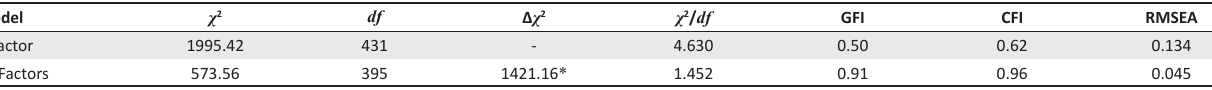
TABLE 2: Confirmatory factor analysis for the study variables Model